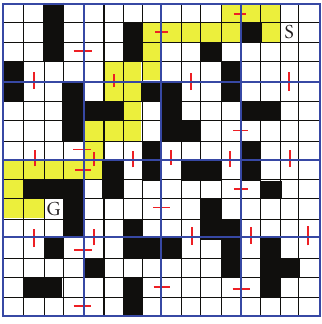
Figure 12: Path refinement with cost